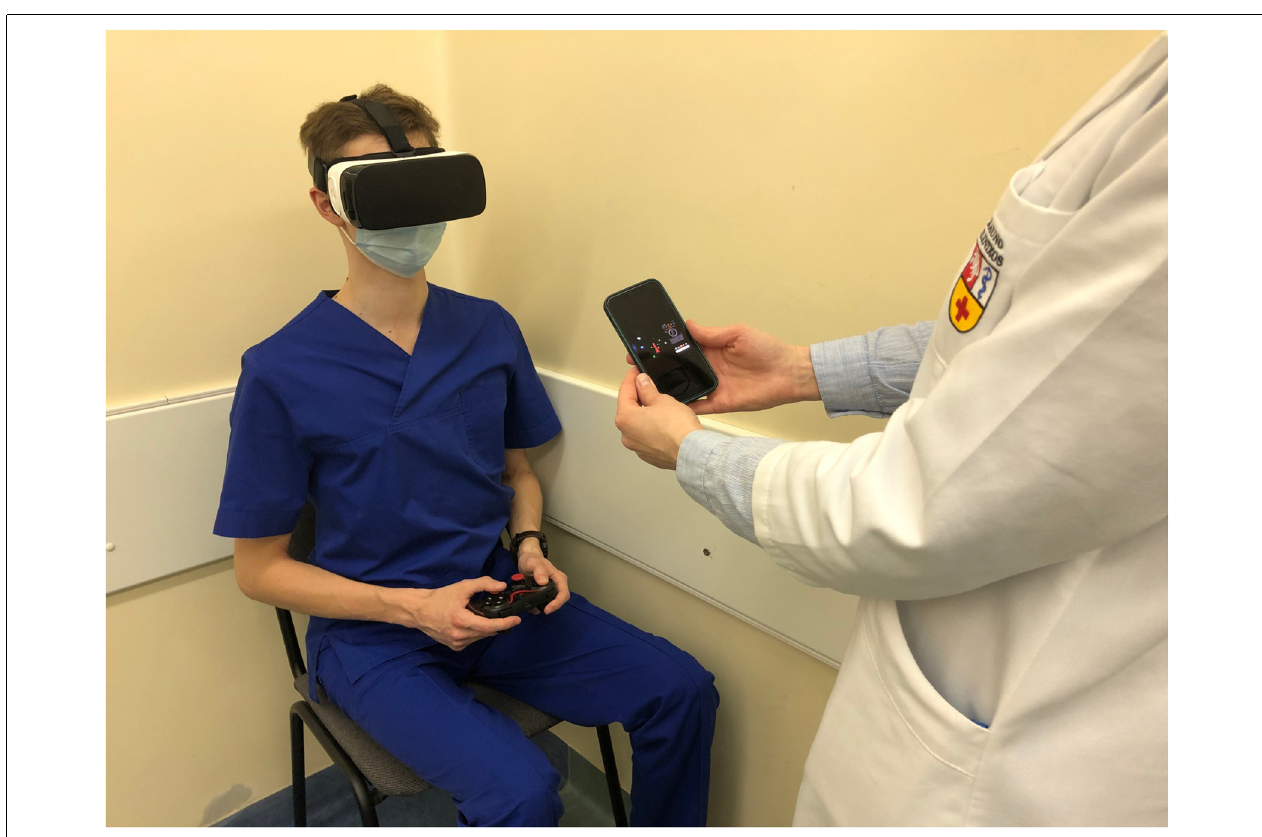
FIGURE 1 | Testing with the VIRVEST system (consent statement